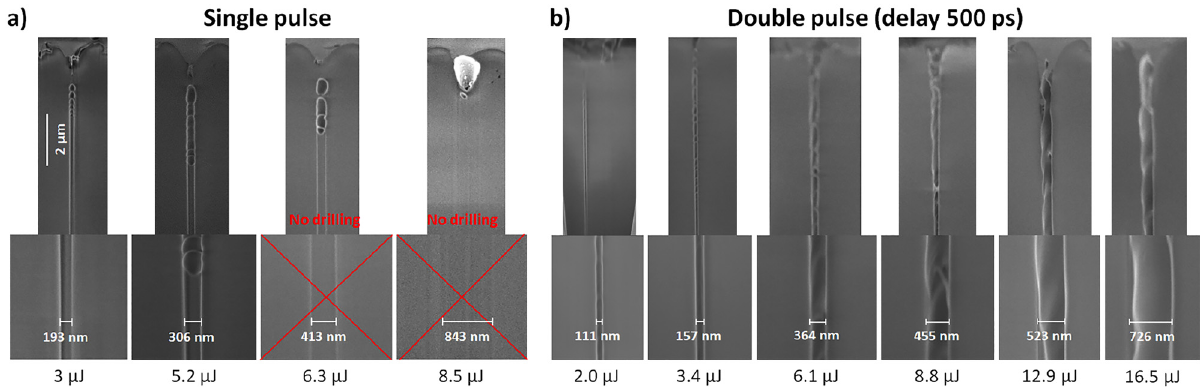
Figure1: Scanningelectronmicroscopy(SEM)imagesofchannelsdrilledusingsinglepulses(a)anddoublepulses(b).Theinsetscorrespond to a zoom in the images. The diameter of the channels is shown in the insets. The energy indicated corresponds to the total